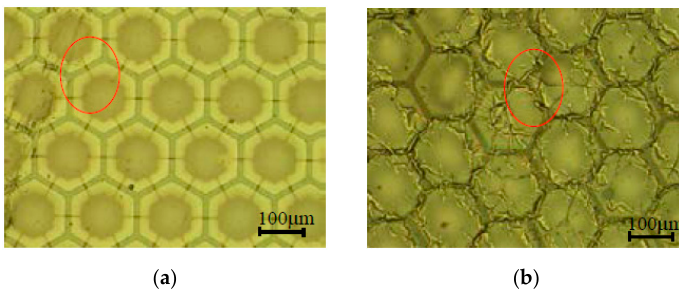
Figure 12. ( a ) Cracks on the ITO top electrode after the pulse-echo test; ( b ) Cracks on the AZO top electrode after the pulse-echo test.